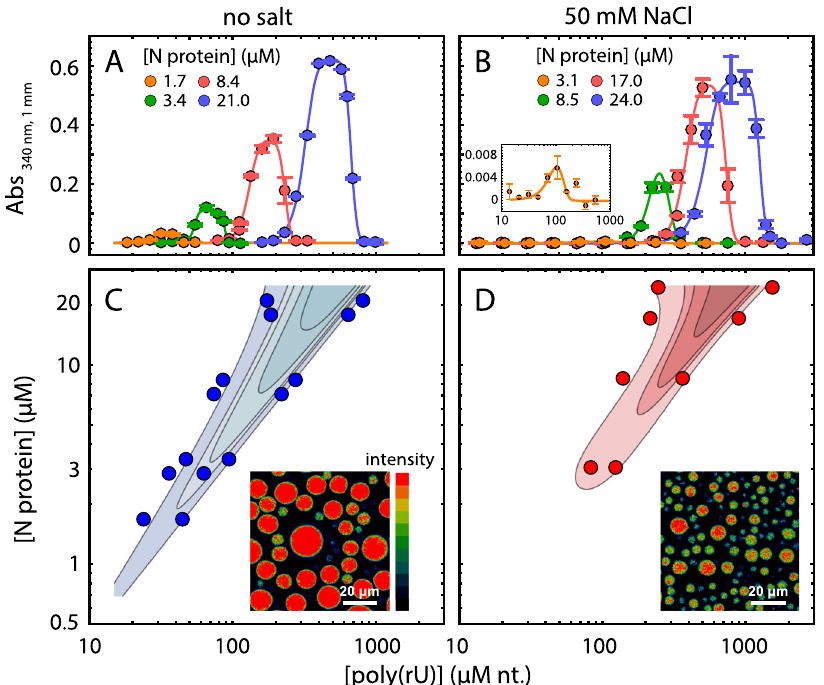
Fig. 5 Nucleocapsid protein undergoes phase separation with RNA. A , B Appearance of solution turbidity upon mixing was monitored to determine the concentration regime in which N protein and poly(rU) undergo phase separation. Representative turbidity titrations with poly(rU) in 50 mM Tris, pH 7.5 (HCl) at room temperature, in the absence of added salt ( A ) and in the presence of 50 mM NaCl ( B ), at the indicated concentrations of N protein. Points and error bars represent the mean and standard deviation of 2 (absorbance < 0.005) and 4 (absorbance ⩾ 0.005) consecutive measurements from the same sample. Solid lines are simulations of an empirical equation fi tted individually to each titration curve (see SI). An inset is provided for the titration at 3.1 μ M N protein in 50 mM NaCl to show the small yet detectable change in turbidity on a different scale. C , D Projection of phase boundaries for poly(rU) and N protein mixtures highlights a re-entrant behavior, as expected for phase separations induced by heterotypic interactions. Turbidity contour lines are computed from a global fi t of all titration curves (see SI). Insets: confocal fl uorescence images of droplets doped with fl uorescently labeled N protein. Total concentrations are 22 μ M N protein, 0.5 nM labeled N protein, and 0.54 mM nt. poly(rU). At a higher salt concentration, a lower concentration of protein in the droplet is